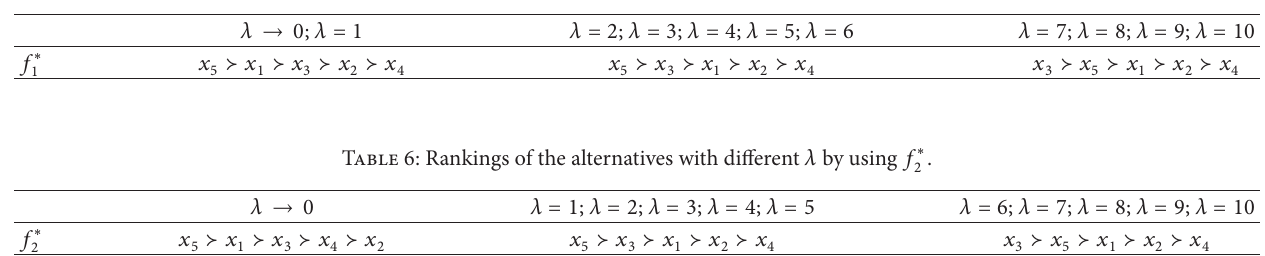
Table 5: Rankings of the alternatives with different 𝜆 by using 𝑓 ∗ 1 .